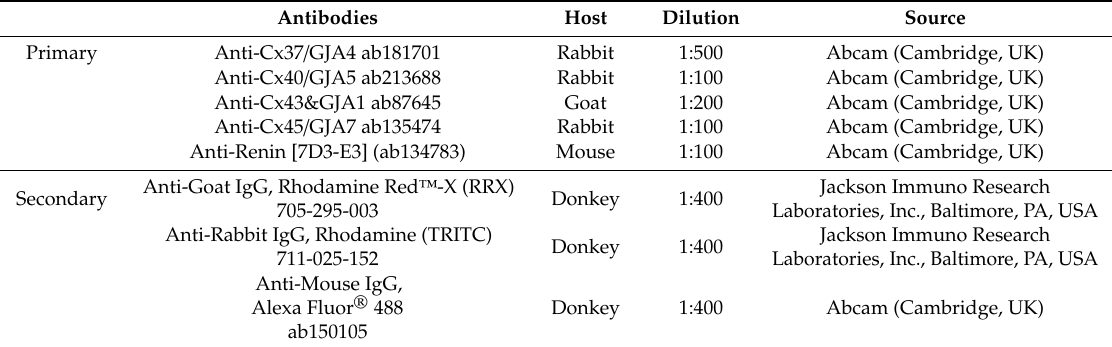
Table 2. Primary and secondary antibodies used in the